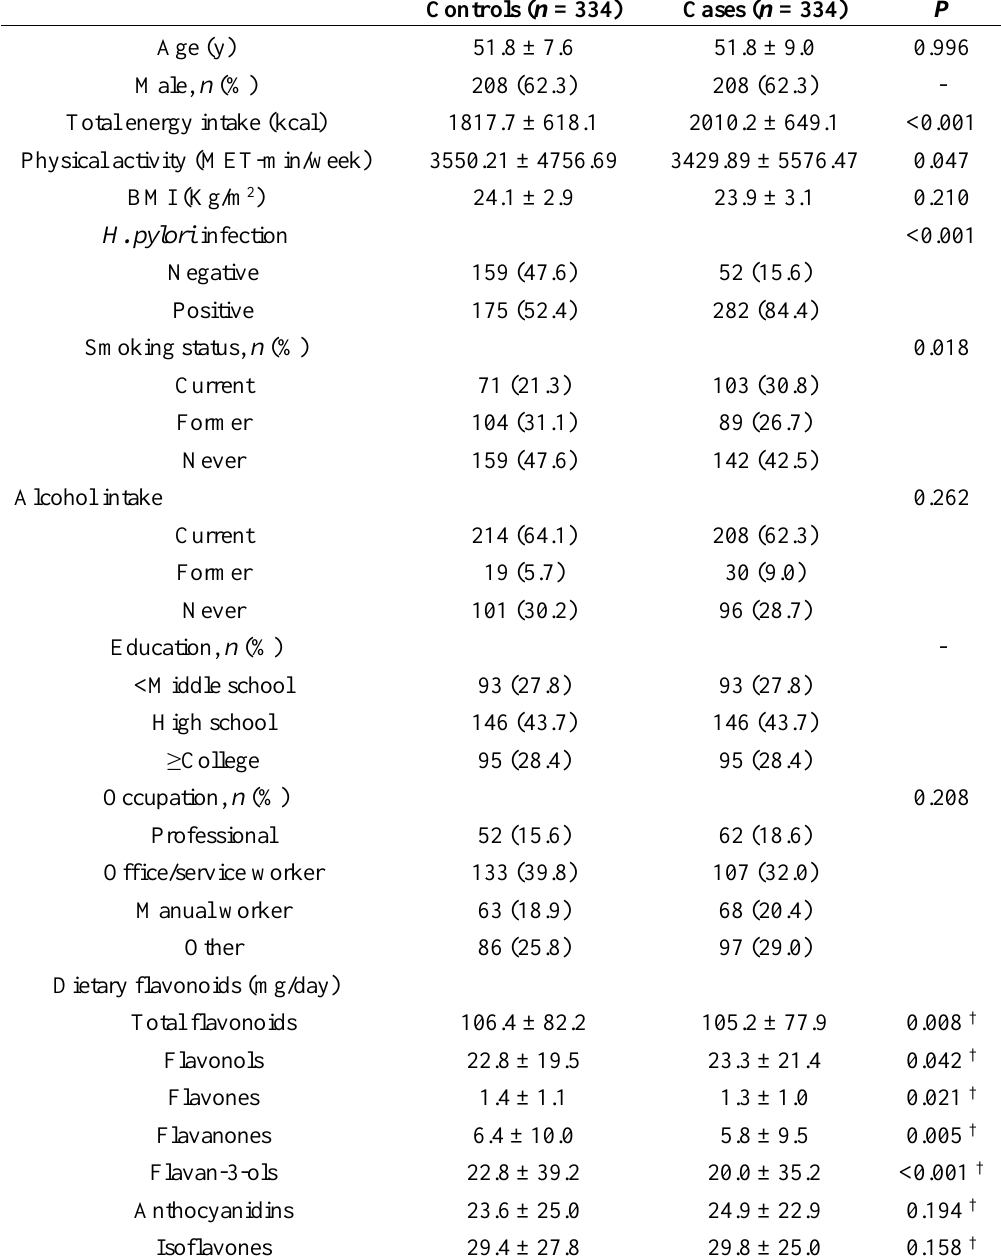
Table 1. General characteristics of the study